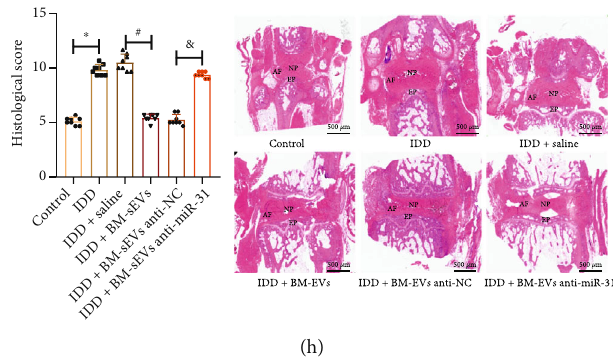
Figure 8: miR-31 in hBMSC-EVs relieves IDD in mice: (a) representative fl uorescence micrographs showing PKH26-labeled EVs in IVD tissues of IDD mice treated with BMSCs-EVs or combined with anti-miR-31. Scale bar = 50 μ m. (b) miR-31 expression in IVD tissues; (c) serum levels of in fl ammatory factors in IDD mice treated with BMSCs-EVs or combined with anti-miR-31 determined by ELISA; (d) protein expression of NFAT5 and β -catenin in IVD tissues of IDD mice treated with BMSCs-EVs or combined with anti-miR-31 determined by Western blot; (e) protein expression of cleaved caspase-3, Bax, and Bcl-2 in IVD tissues of IDD mice treated with BMSCs-EVs or combined with anti-miR-31 determined by Western blot; (f) protein expression of ECM-related genes in IVD tissues of IDD mice treated with BMSCs-EVs or combined with anti-miR-31 determined by Western blot; (g) cell apoptosis determined by TUNEL assay in IVD tissues of IDD mice treated with BMSCs-EVs or combined with anti-miR-31 9 weeks after puncture. Blue fl uorescence (DAPI) indicates the total number of cells; green fl uorescence (FITC) indicates TUNEL-positive cells. Scale bar = 50 μ m. (h) HE staining of IVD tissues of IDD mice treated with BMSCs-EVs or combined with anti-miR-31. Scale bar = 500 μ m. ∗ p < 0 : 05 : n = 8 .